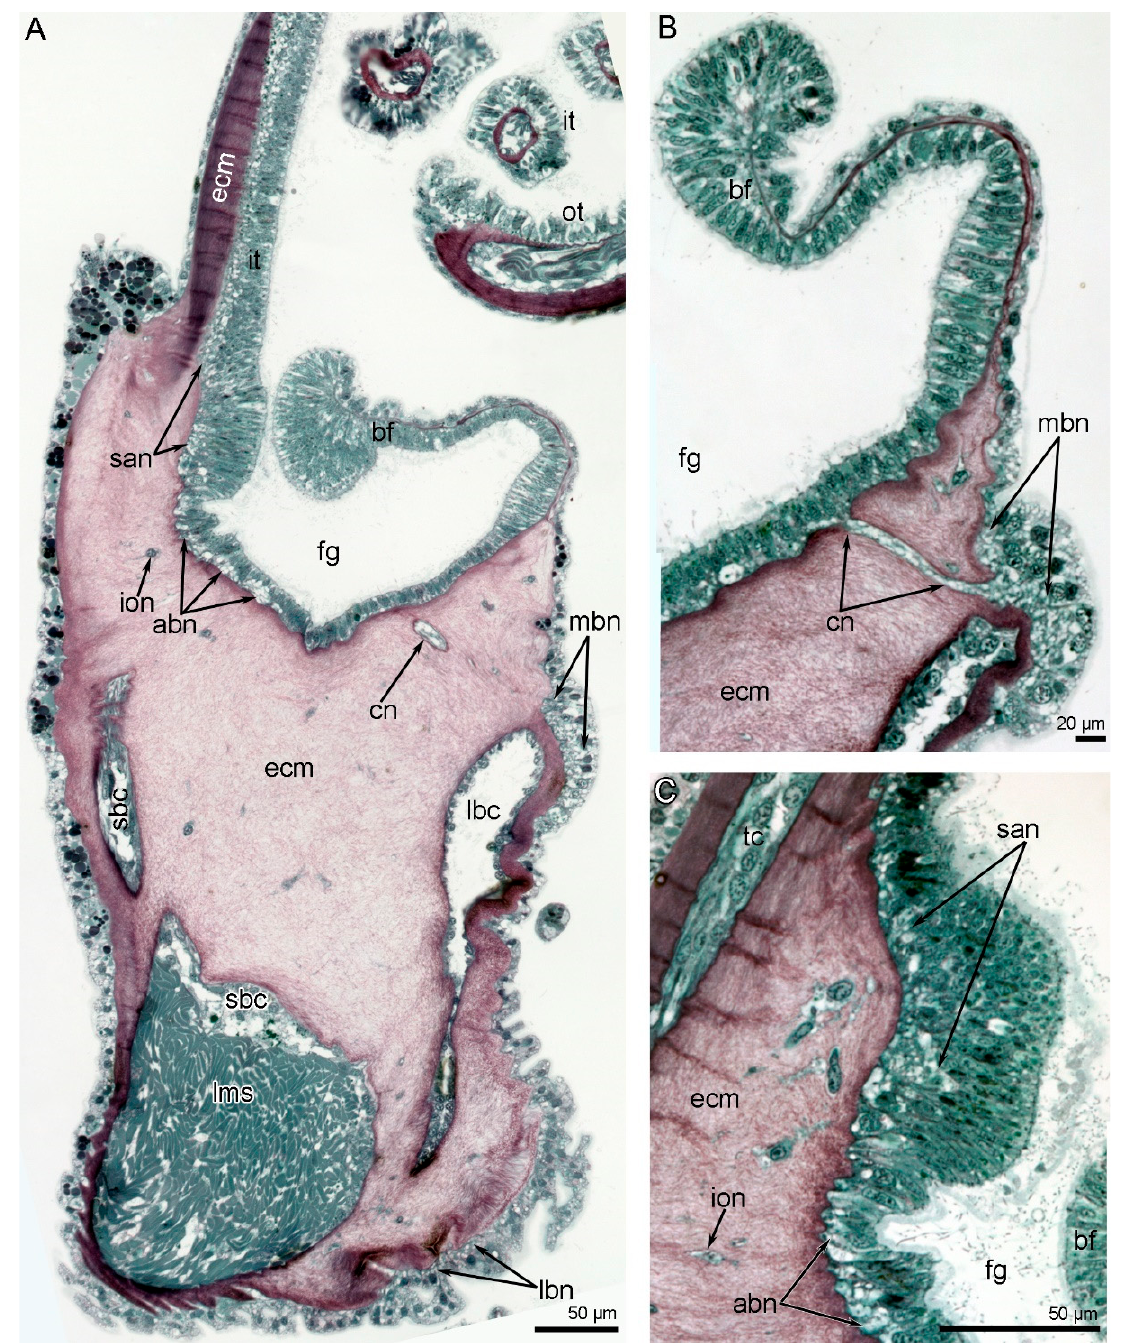
Figure 6. Brachial nerves in the semi-thin cross-sections of the lophophore arm in Novocrania anomala adults. ( A ) General view of a cross-section of the arm: the location of the brachial nerves is evident. ( B ) The main brachial nerve giving rise to the cross nerve. ( C ) Inner side of the base of the double row of tentacles: accessory and second accessory brachial nerves are visible. Abbreviations: